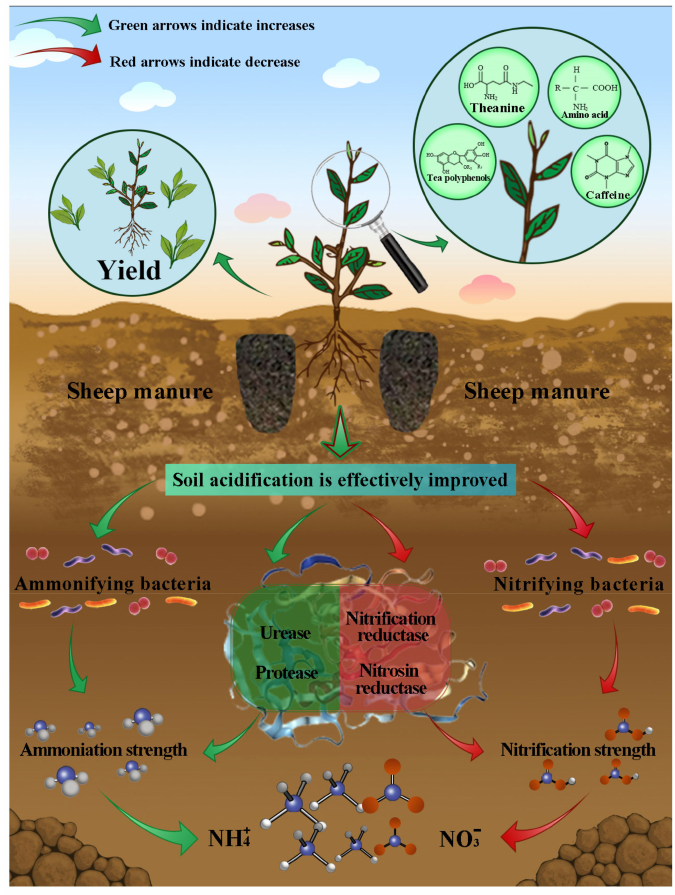
Figure 13. Patterns of effects of sheep manure fertilizer on soil pH, nitrogen transformation, and tea yield and quality in tea